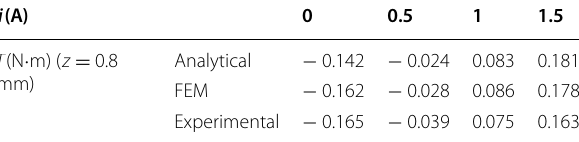
Table 6 Comparison of torque-displacement characteristics